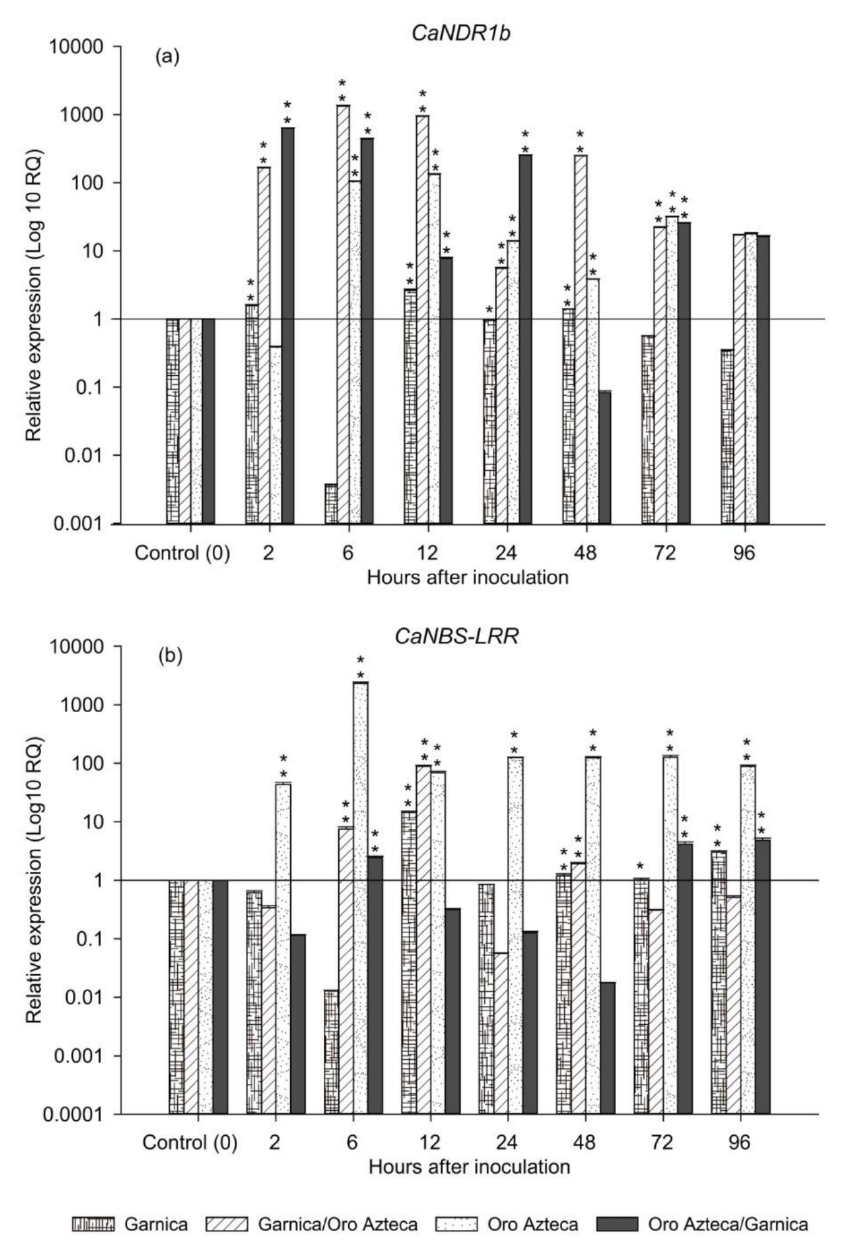
Figure 3. Relative expression of the pathogen recognition genes CaNDR1b ( a ) and CaNBS-LRR ( b ) in grafted and ungrafted plants during 96 hai, and using as control plants at 0 hai. * There were no significant differences between the control and the treatment. ** There were significant differences between the